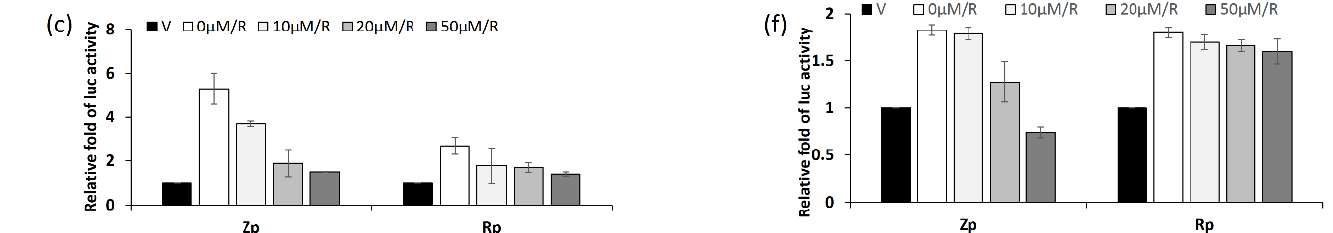
Figure 6. Kaempferol treatment inhibits Zp and Rp activities in NPC cell lines. The effects of kaempferol on Zp and Rp were determined using luciferase assay. NA ( a – c ) and TW01 ( d – f ) cells were transfected with Zp or Rp reporters for 3 h, followed by kaempferol pre-treatment and TPA + SB induction for a further 24 h. Cell lysates were collected to measure luciferase activity of each sample. The values of each sample were derived from three independent trials. The relative fold of luc activity was represented as the relative fold of luciferase activity compared to mock control. TS: